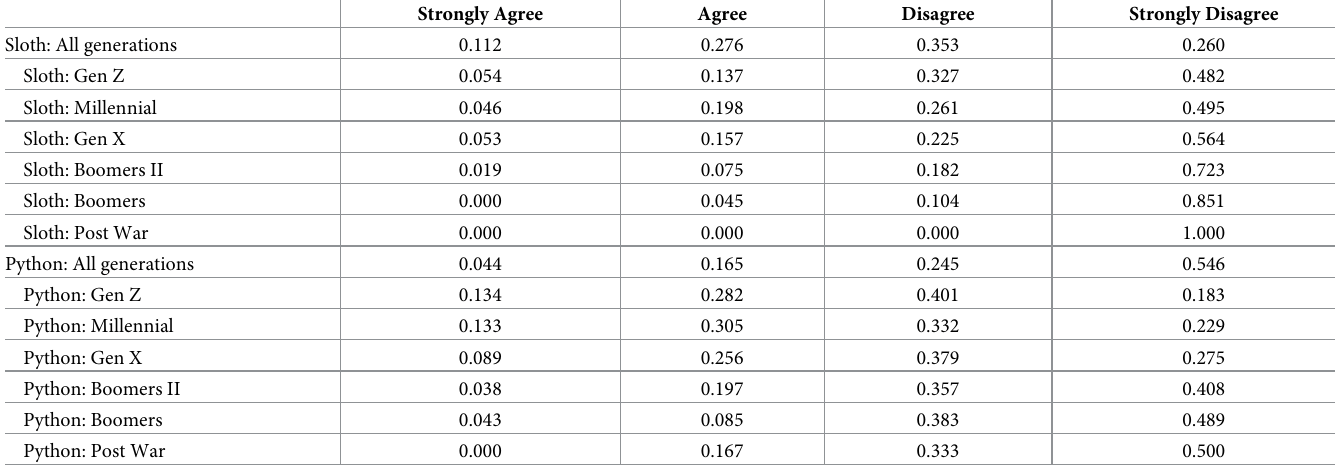
Table 1. Proportion of responses by level of agreement with the statement, “I would like to have a sloth/python as a pet”.